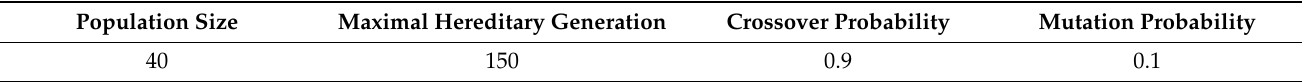
Table 5. Parameters of genetic algorithm. Population Size Maximal Hereditary Generation Crossover Probability Mutation Probability 40 150